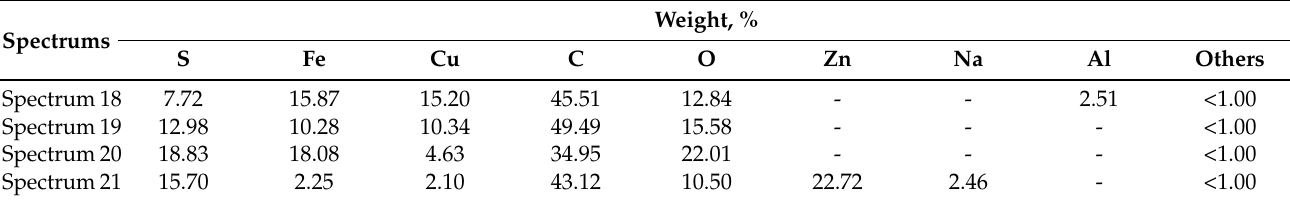
Table 6. EDS analysis done in selected particles of